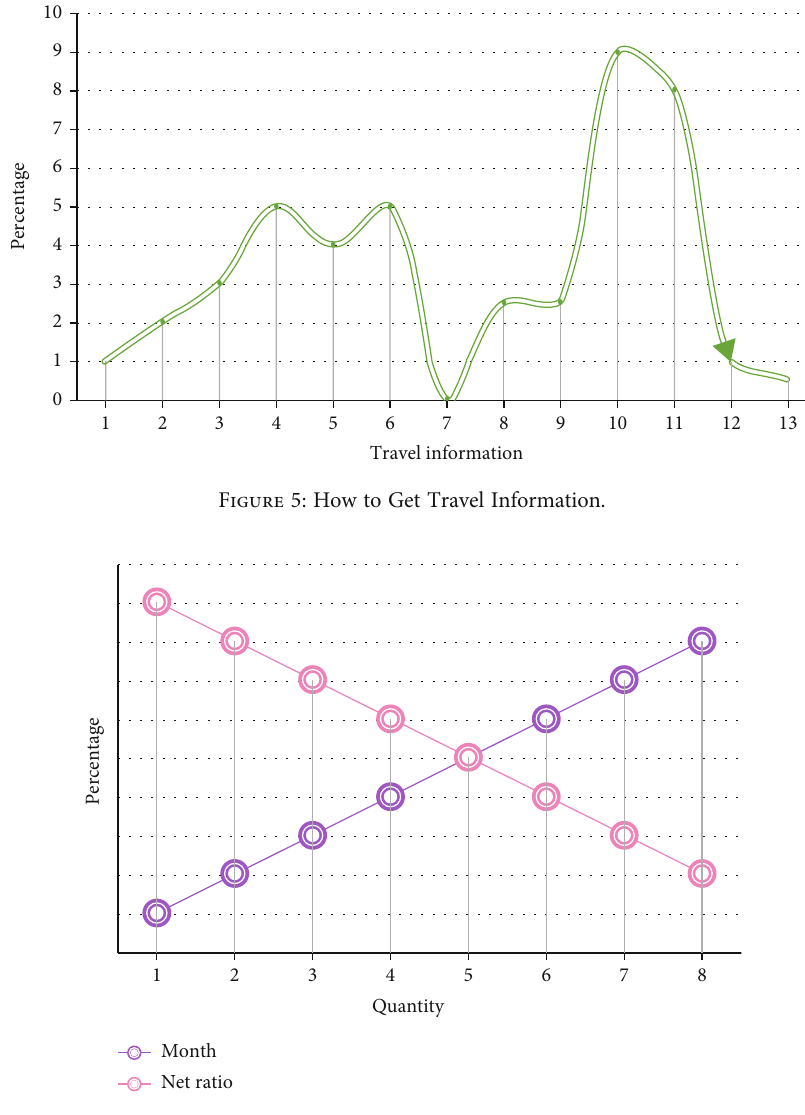
Figure 6: Tourist